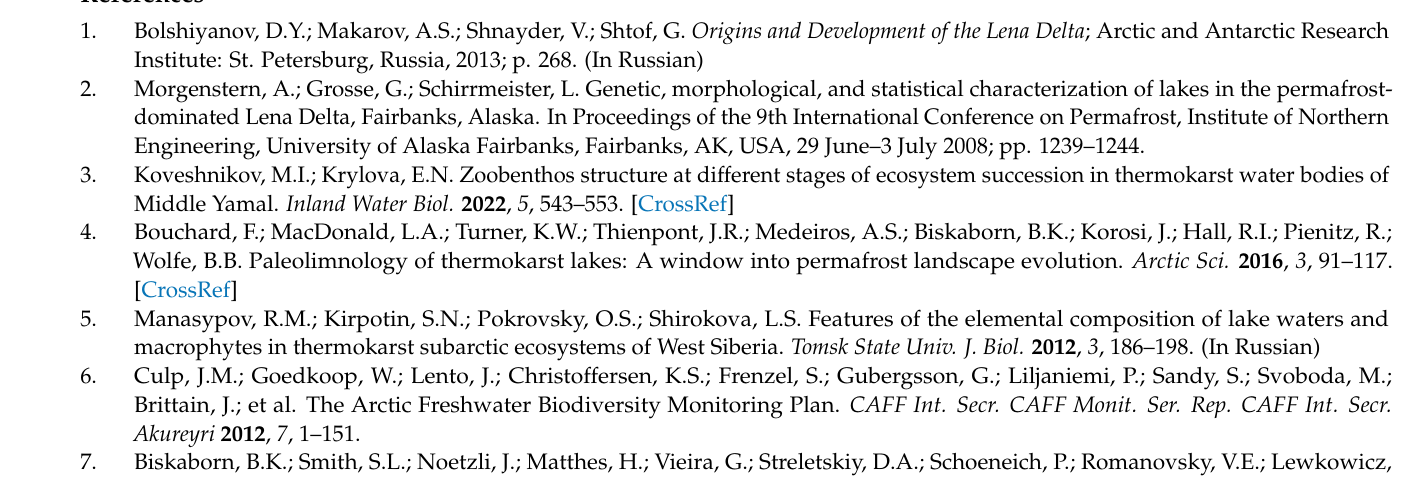
Table S6: Abbreviations list of aquatic species from the Lena River